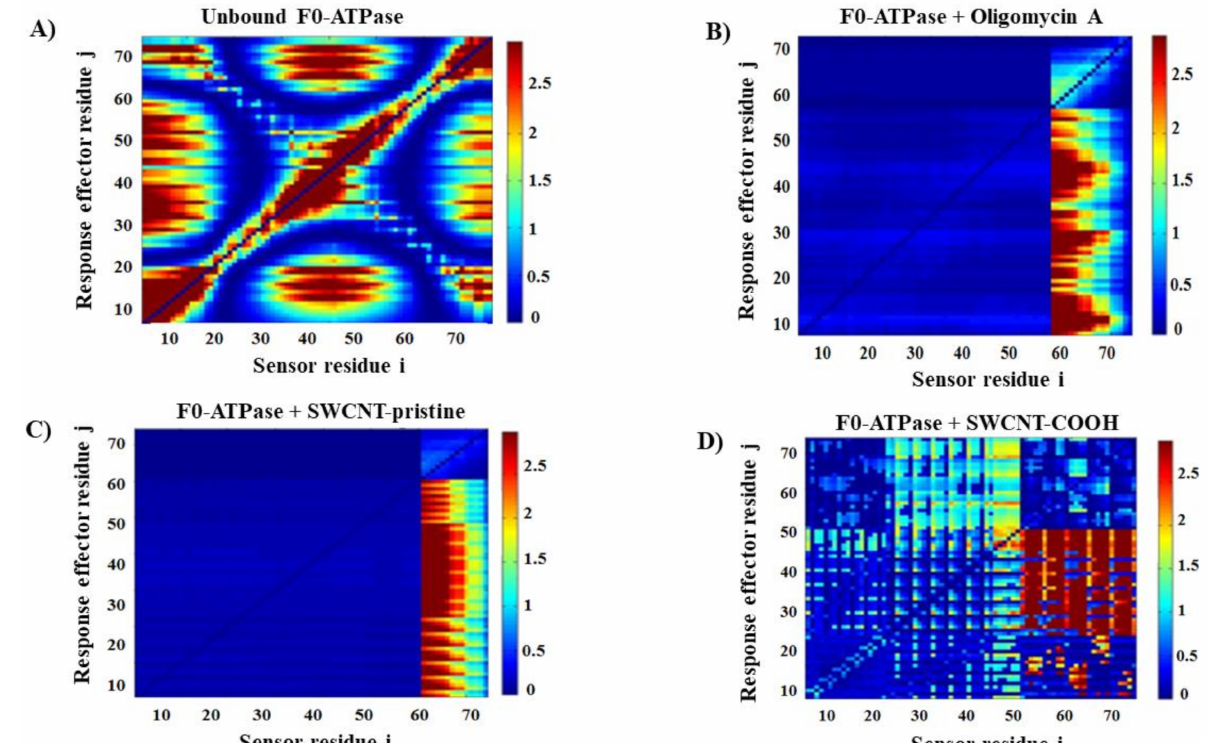
Figure 4. Perturbation response analysis for the F0-ATPase inhibition response. ( A ) LPRS map obtained for the unbound F0-ATPase as the control simulation experiment. Individual LPRS maps obtained from the best docking complexes (in the bound state for all the ligands tested) with intensity bar color representing the i,j residue perturbations (on the right) for: ( B ) oligomycin A/F0-ATPase complex, ( C ) SWCNT-pristine/F0-ATPase complex, and ( D ) SWCNT-COOH/F0-ATPase complex. All the LPRS maps were established in range of the low-frequency normal modes in order to capture relevant fluctuations associated with F0-ATPase catalytic function across the different conditions